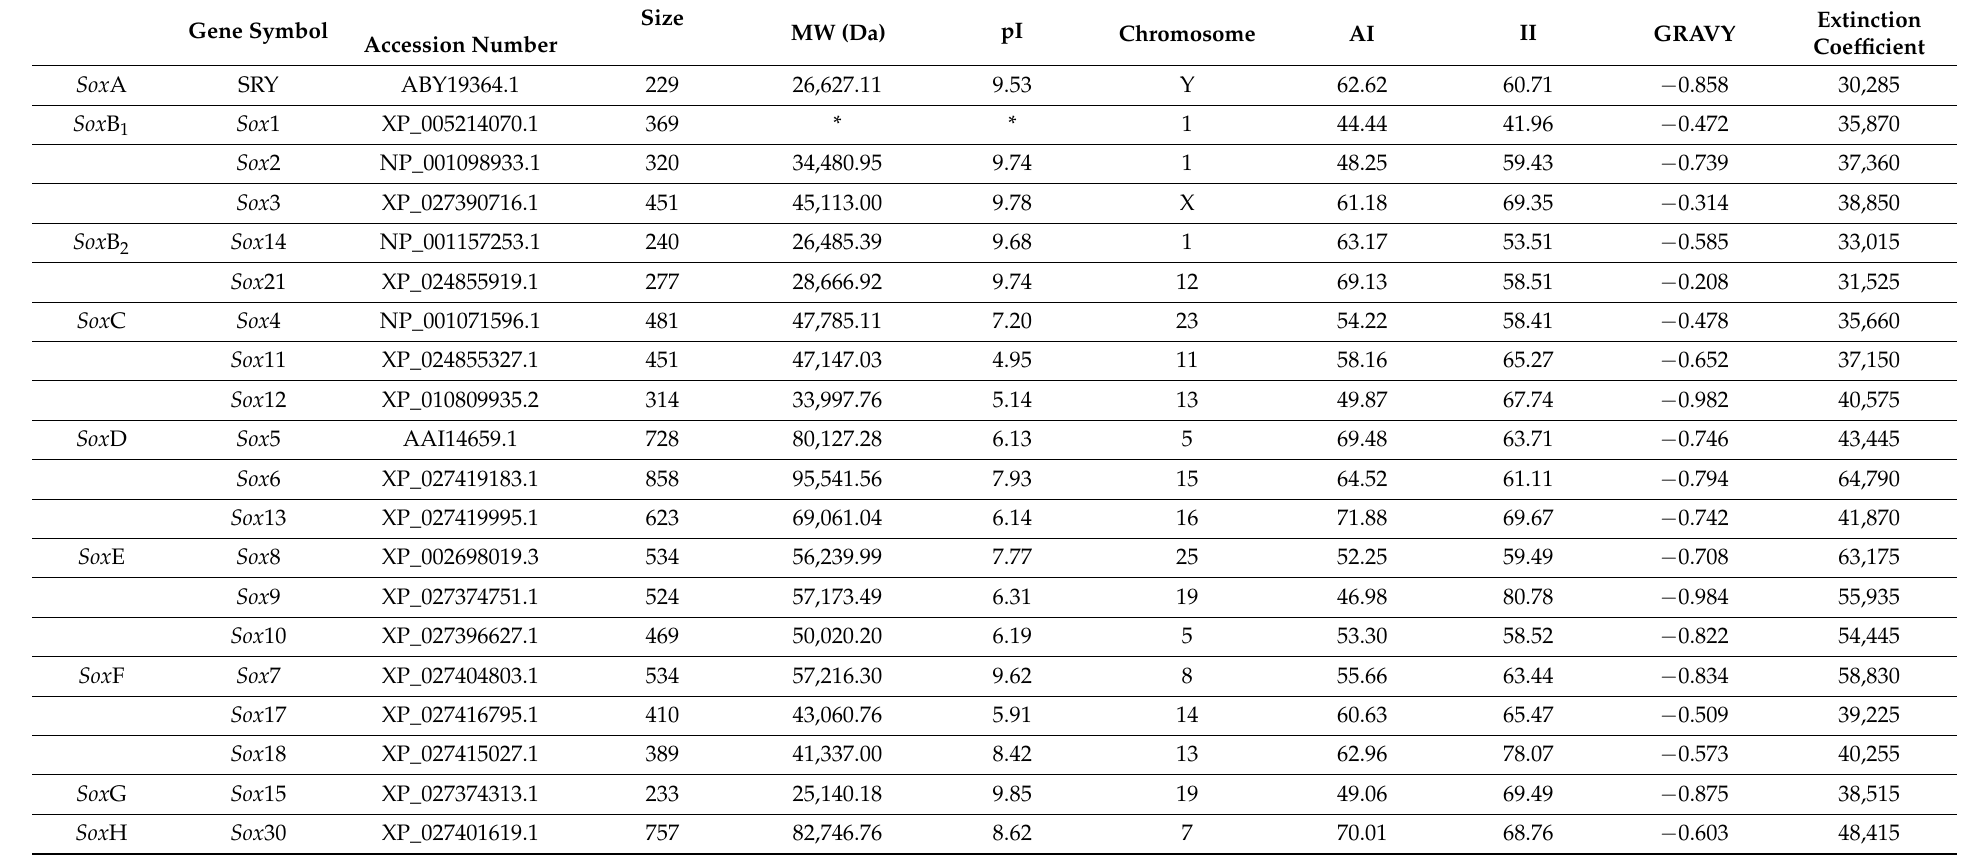
Table 1. Physicochemical properties of Sox genes in Bos